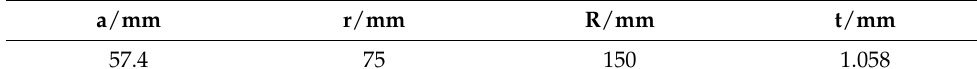
Table 1. Geometrical dimensions of toroidal pressure hulls.